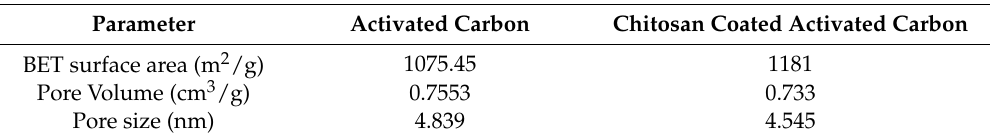
Table 1. Characteristics of adsorbent.